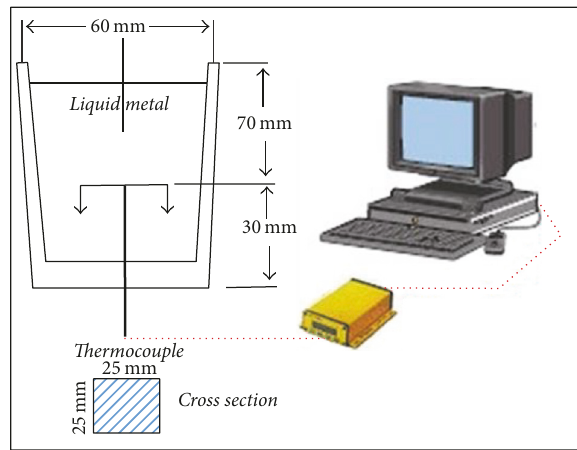
Figure 1: Schematic drawing showing the graphite mold used for thermal